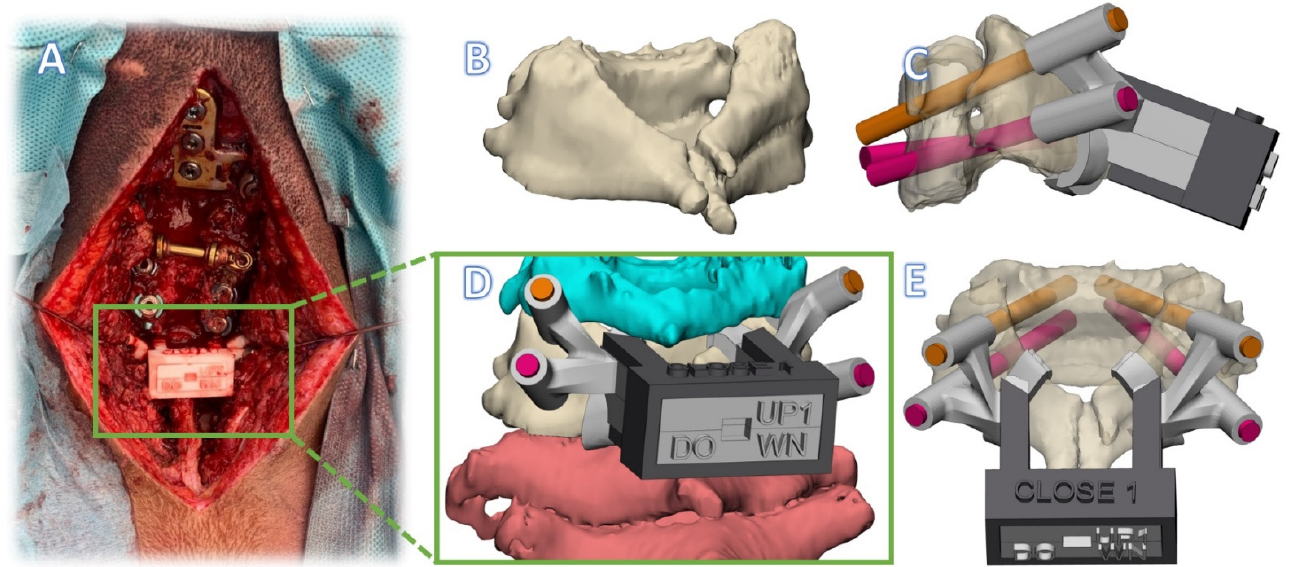
Figure 8. Click-on guide case 3. ( A ) Intraoperative photo. ( B ) Fused vertebrae C5-C6. ( C ) Lateral view of alternative guide design with four pedicle guides from two levels in click-on guide system. ( D ) Rendering of guide with cranial and caudal vertebrae also visible. ( E ) Posterior view of the guide system.